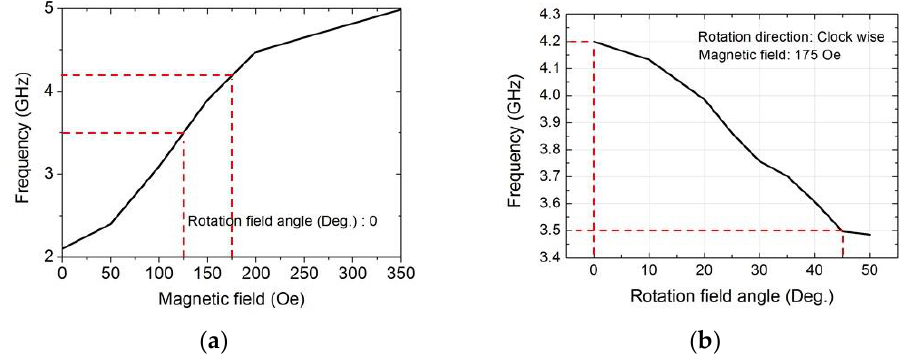
Figure 2. Spintronic oscillation characteristics of the fabricated STNO depending on ( a ) the magnetic field and ( b ) the rotation field angle at the condition of IDC = 1.5 mA. (1 Oe (Oersted) = 1 Gauss in air = 0.1 millitesla).